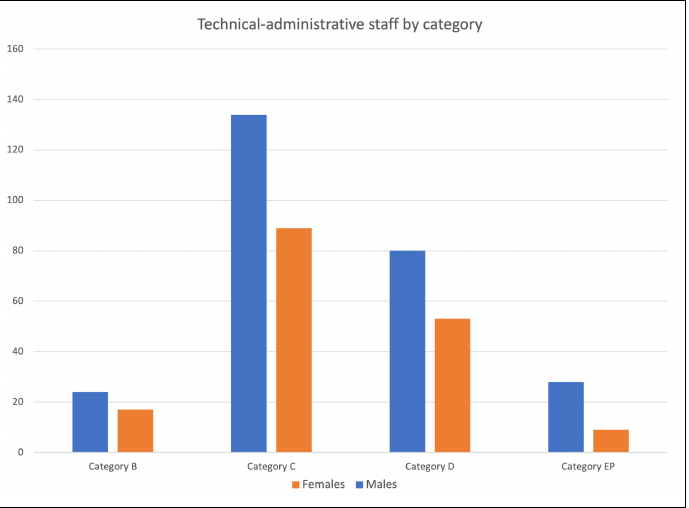
Figure 3. Composition of technical–administrative